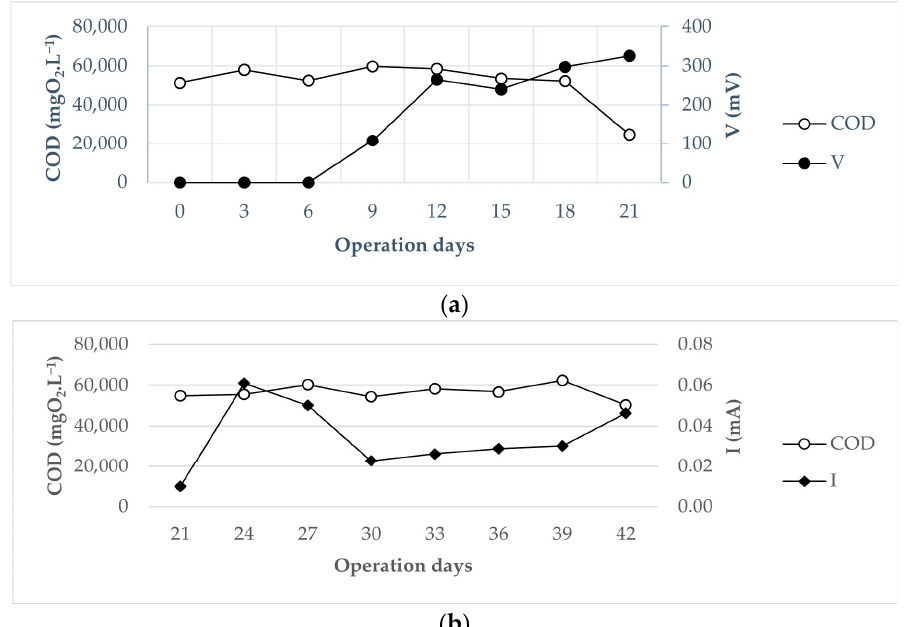
Figure 8. COD rate results for each experiment using the experimental design: ( a ) MFC in open- circuit operation; ( b ) MFC in closed-circuit operation.